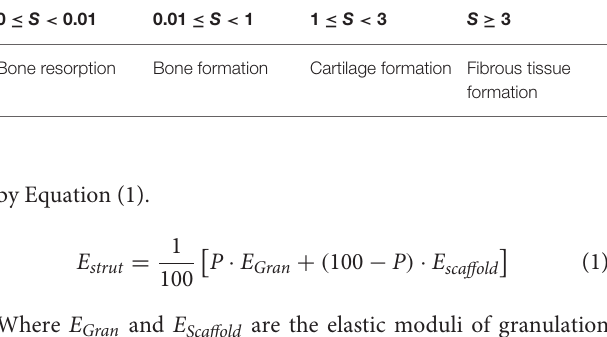
TABLE 3 | Thresholds of S to describe the mechanics-dependent tissue formation (Kelly and Prendergast, 2005). 0 ≤ S < 0.01